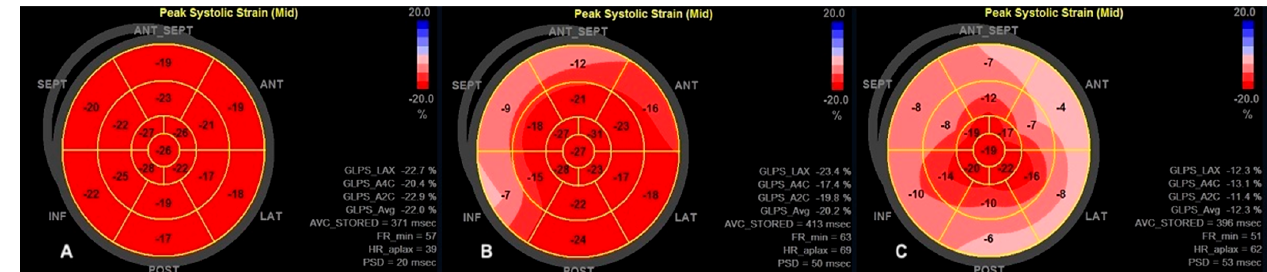
Figure 2. The example of 2D LA strain analysis derived from a four-chamber apical view of a healthy person ( A ); HCM patient without FA diagnosis ( B ); HCM patient with FA diagnosis ( C ).